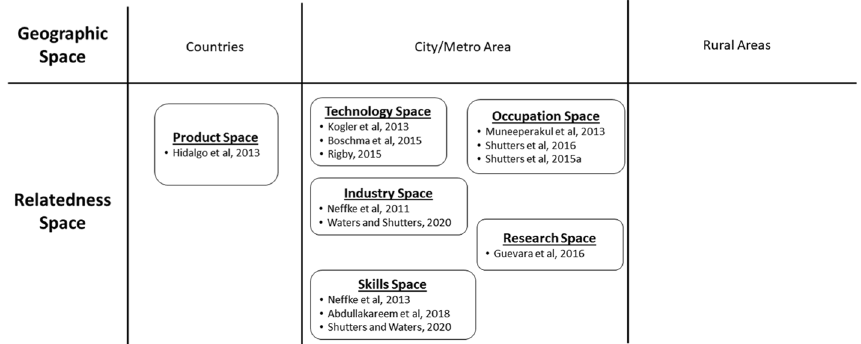
attention in the